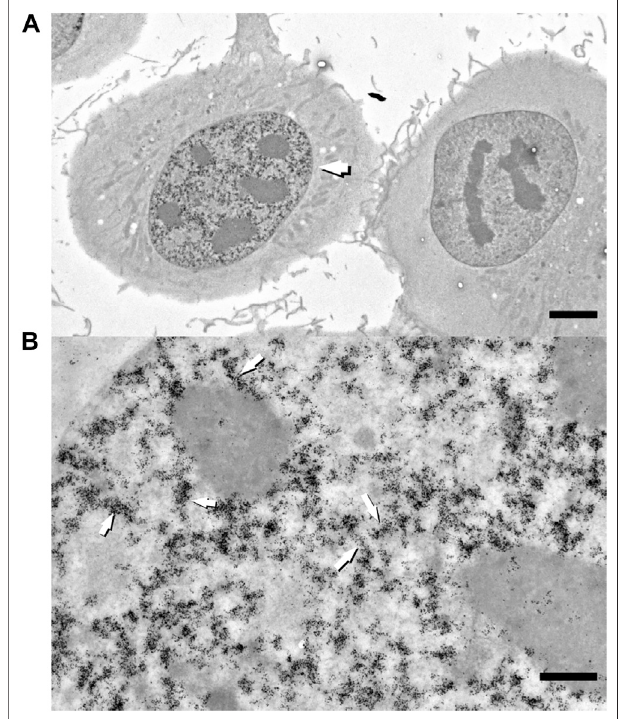
FIGURE 3 | Raw zero-tilt image of a 250-nm-thick section of HT1080 cell in early S-phase labeled with 2 h pulse of EdU with subsequent detection with biotin-azide – streptavidin-Nanogold (A) . Segments of labeled fi ber-like chromatin structures (arrows) are randomly distributed throughout nuclear interior. Bar, 1 μ m (A) and 0.5 μ m (B) .